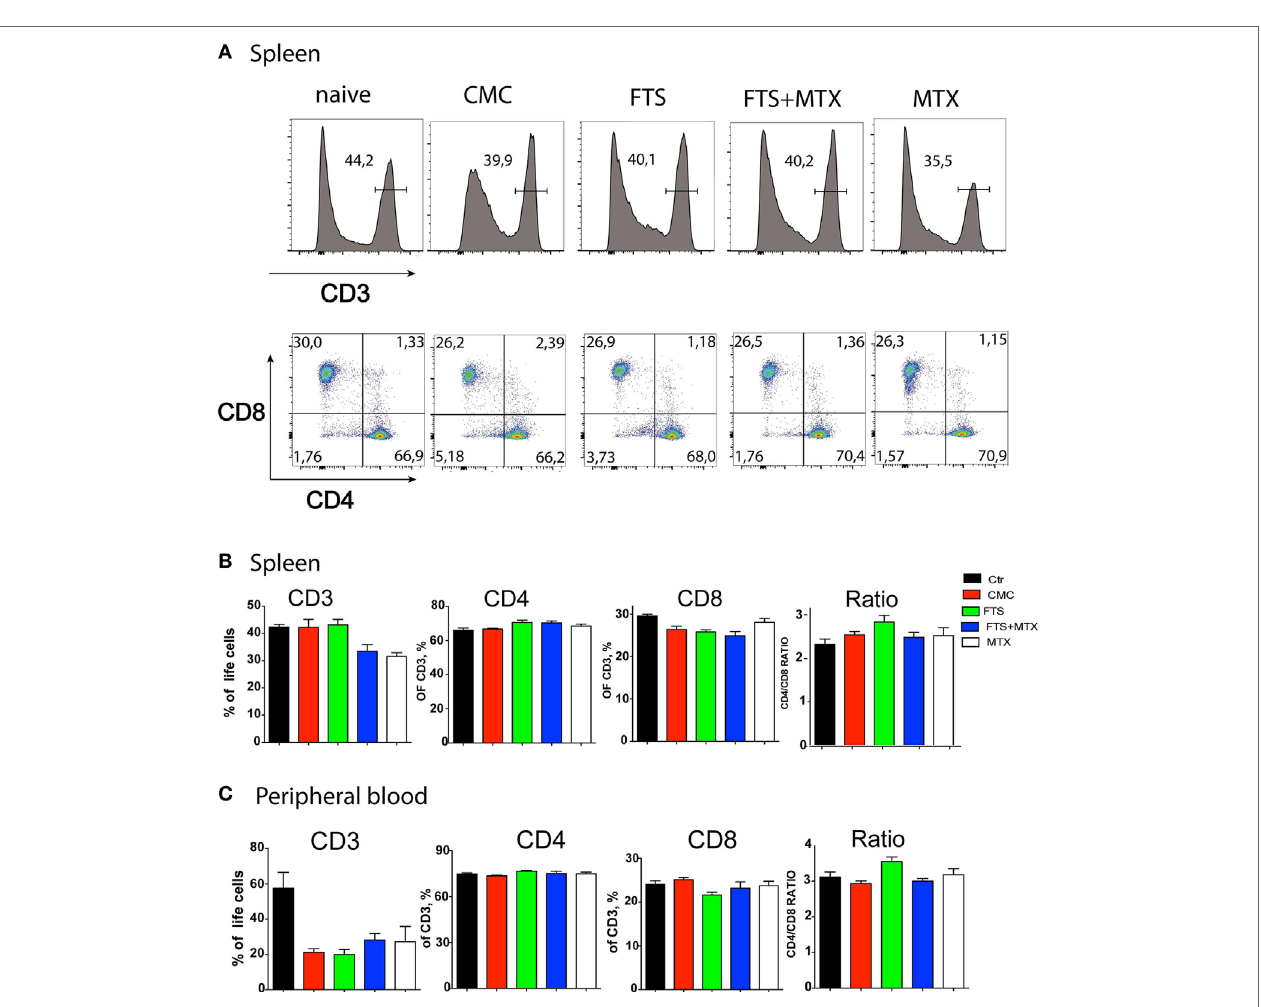
FigUre 3 | Effects of farnesylthiosalicylic acid (FTS) therapy on splenic and peripheral blood T cell populations. At study termination, single cell suspension of spleens (a,B) and peripheral blood (c) from the various groups of treated rats ( n = 8 per group) were analyzed by flow cytometry for CD3 + CD4 + , and CD8 + T cell frequencies. Samples were acquired on a FACSAria instrument (~50,000 single cell events per sample) and analyzed using the FlowJo software. The results shown represent a typical experiment out of > 5 performed.